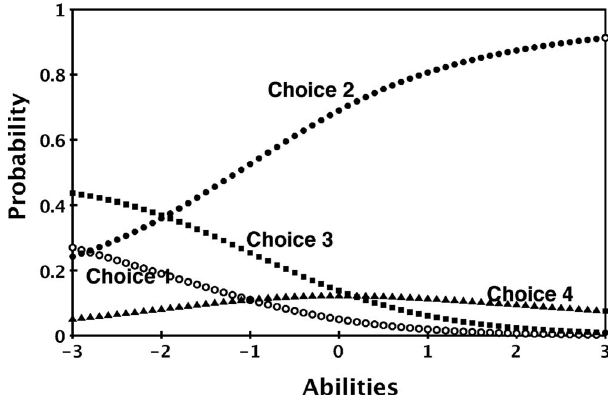
FIG. 14. Trace lines for alternative choices of one MIET item (cid:1) Q30 (cid:2)